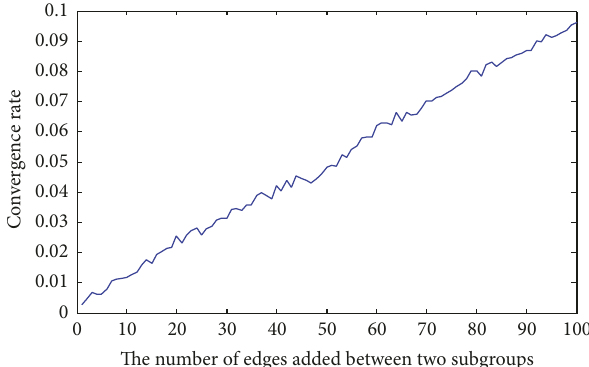
Figure 1: The relationship between the number of edges added between two subgroups and the convergence time.